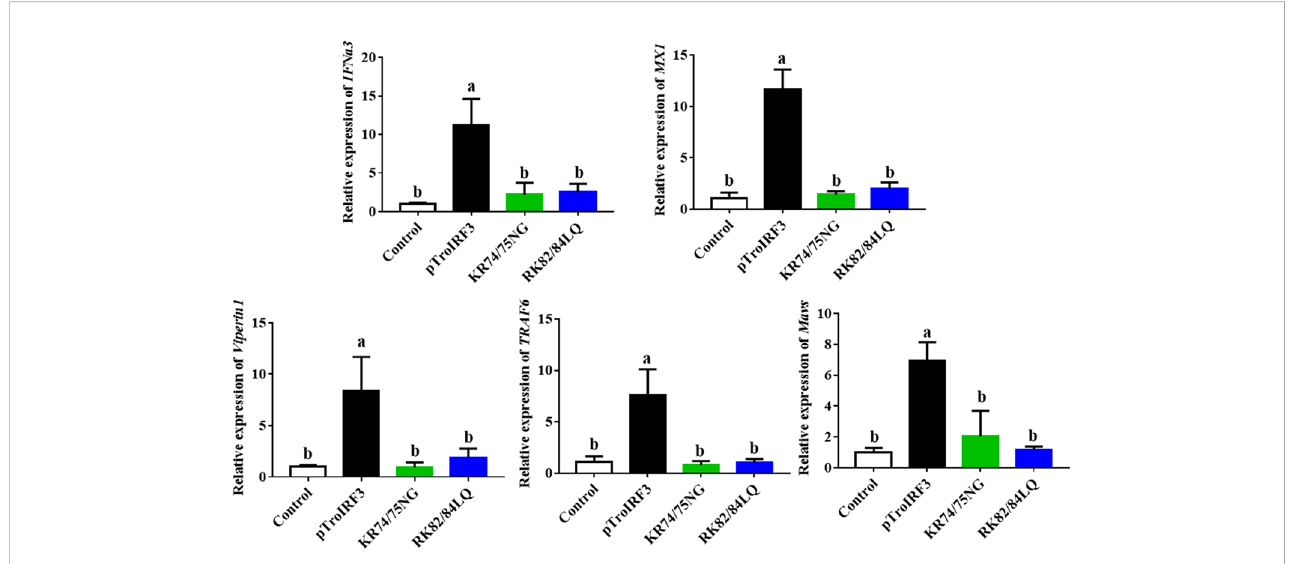
FIGURE 7 The function of NLS in the expression of interferon signaling molecules induced by TroIRF3. Golden pompano injected with pTroIRF3, pTroIRF3-KR74/ 75NG, pTroIRF3-RK82/84LQ, or PBS (control). After fi ve days, the expression level of interferon signaling molecules in the spleen was detected. The results represent the mean ± SD (N=3), and N indicates the number of fi sh used per group. Signi fi cant differences ( P < 0.05) are indicated by different letters, and no signi fi cant differences are indicated by the same